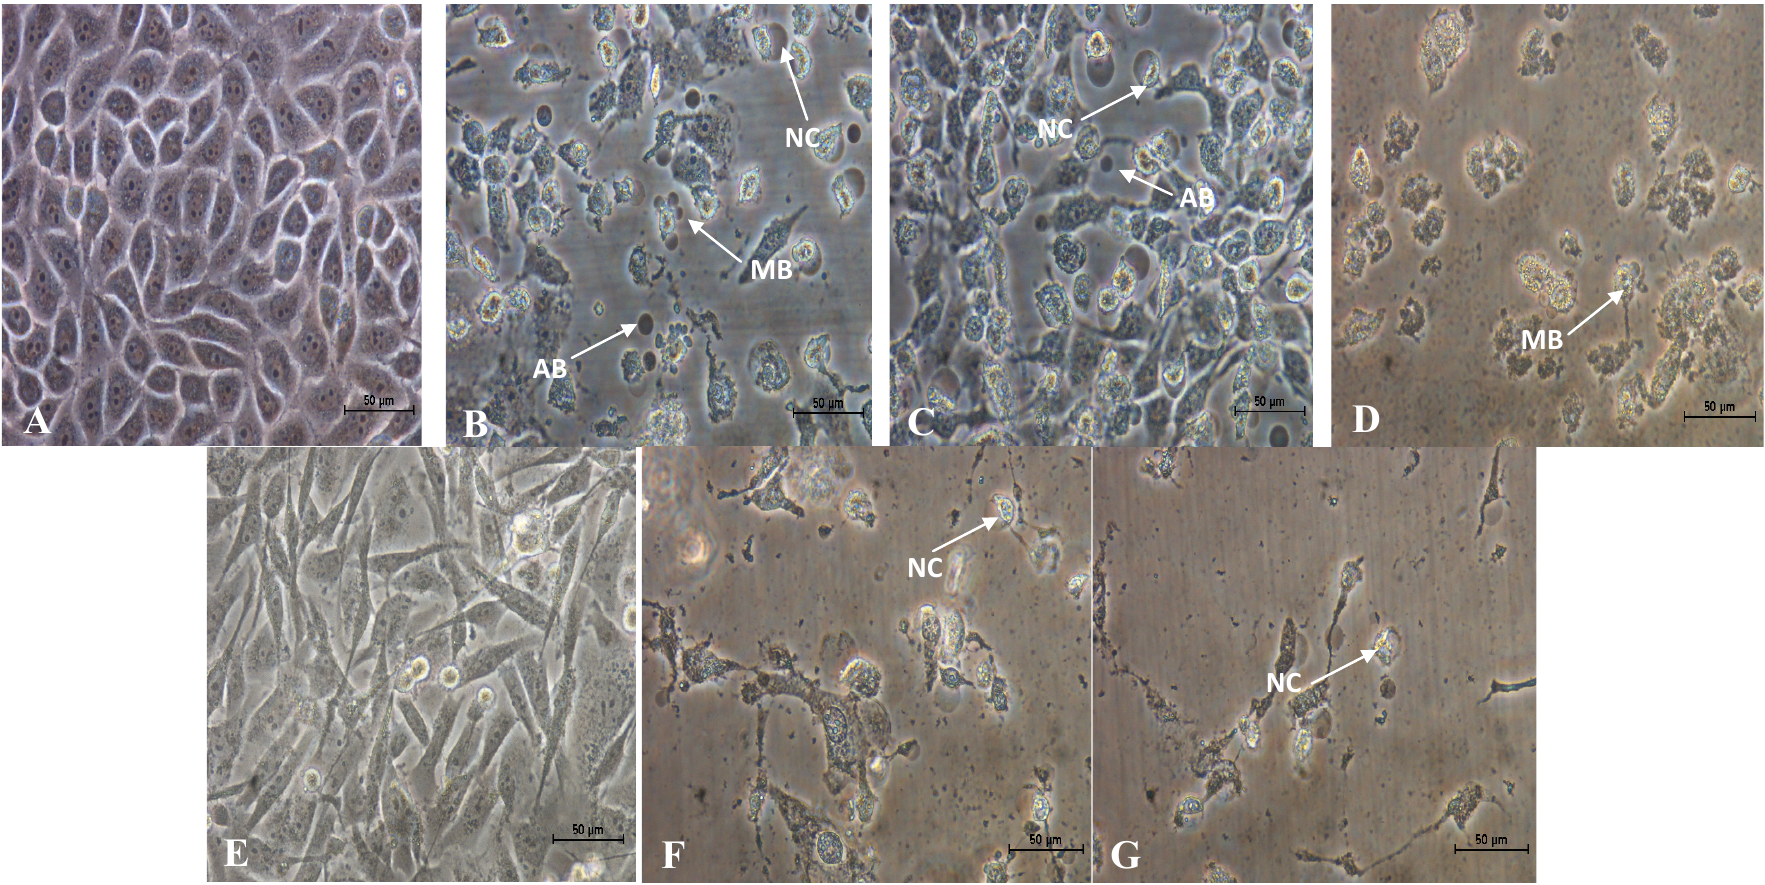
Figure 2. Close-up views of MCF-7( B , C and D ) and MDA-MB-231( F and G ) cells treated with ( B and F ) 12.5 µg/mL of D/F4, ( C and G ) 12.5 µg/mL of D/F5 and ( D ) 50.0 µg/mL of EA/P2 of D. suffruticosa for 72 h viewed under an inverted light microscope. The cells